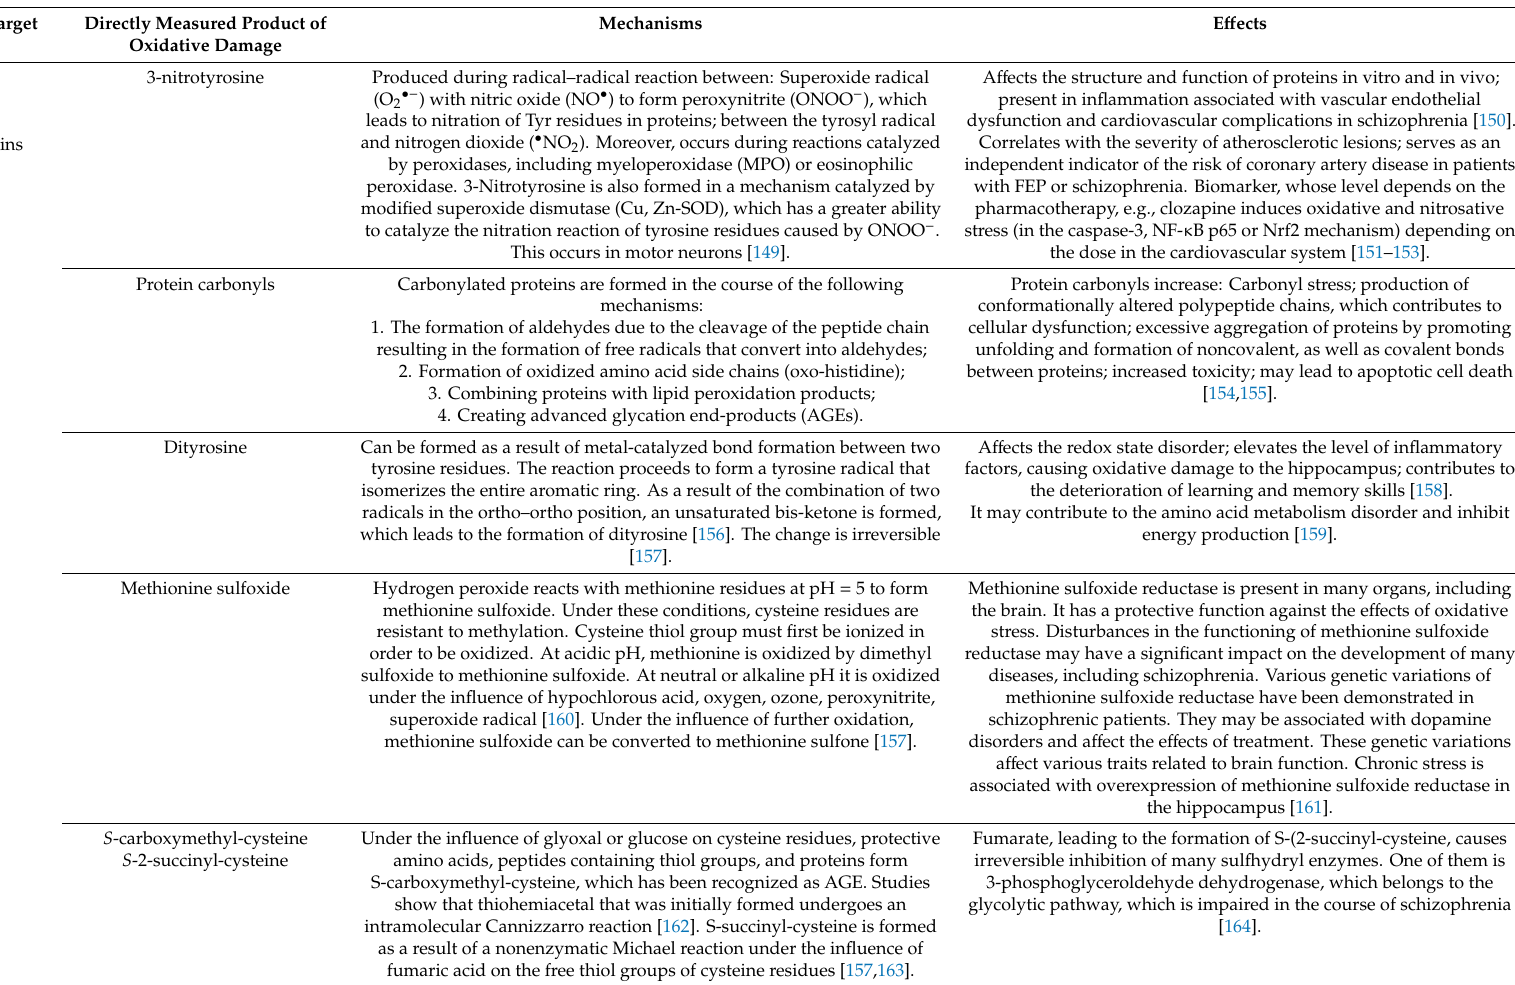
Table 2. Selected peripheral and brain biomarkers of oxidative damage. Biologically important damage to proteins, lipids, and nucleic acids caused by oxidative stress. ROS